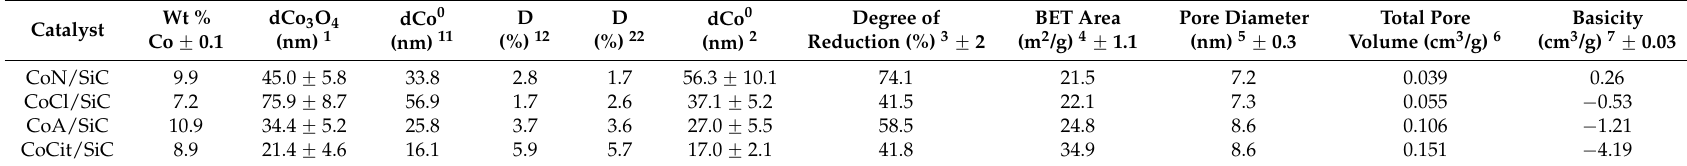
Table 1. Physicochemical properties of FTS C om /SiC